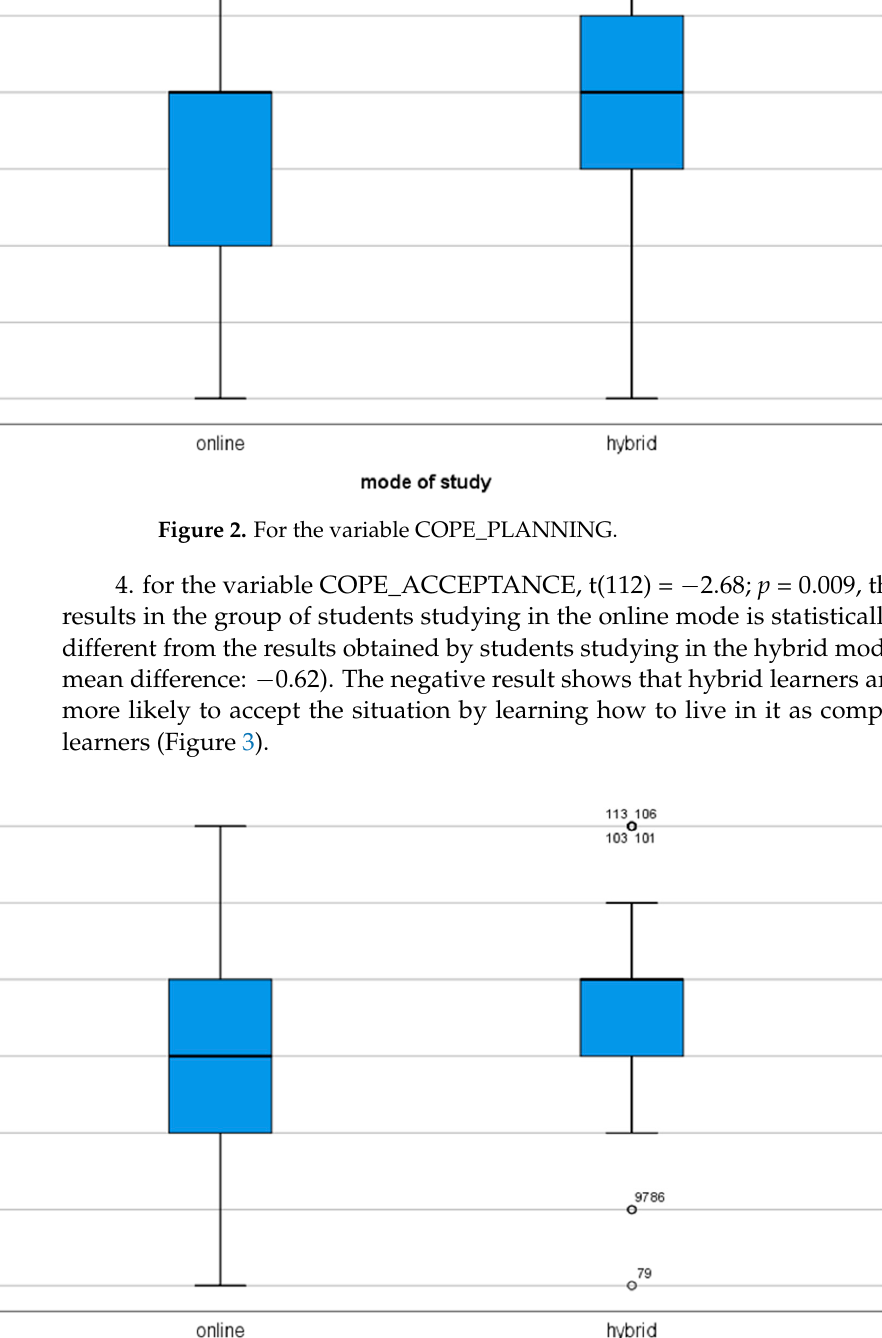
Figure 1. For the variable COPE_ACTIVE COPING WITH STRESS.